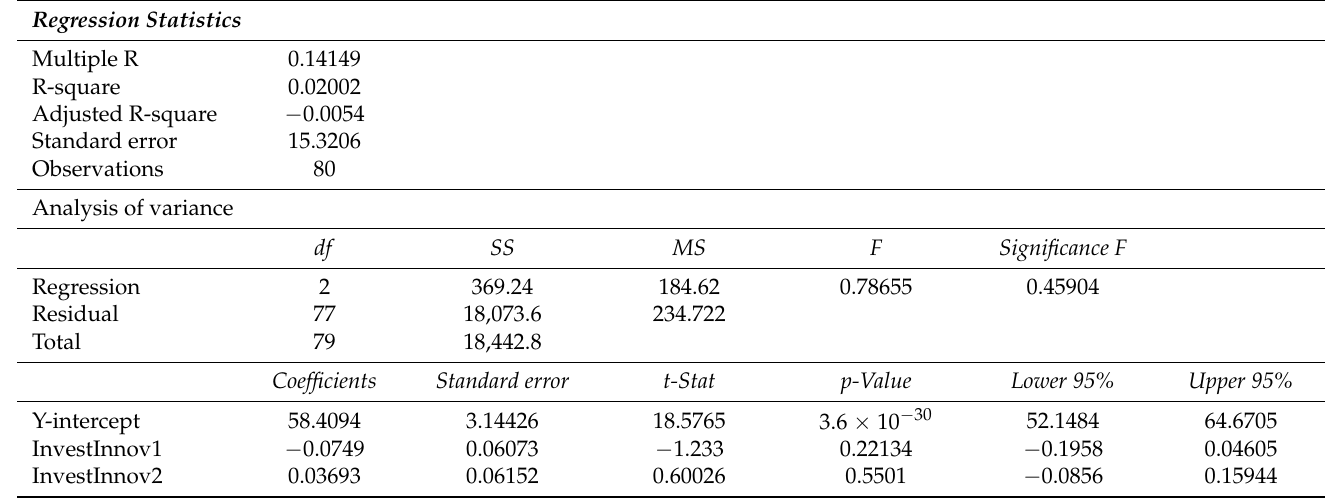
Table A3. Regression statistics of the dependence Srisk 3 on investments in innovation (InvestInnov).